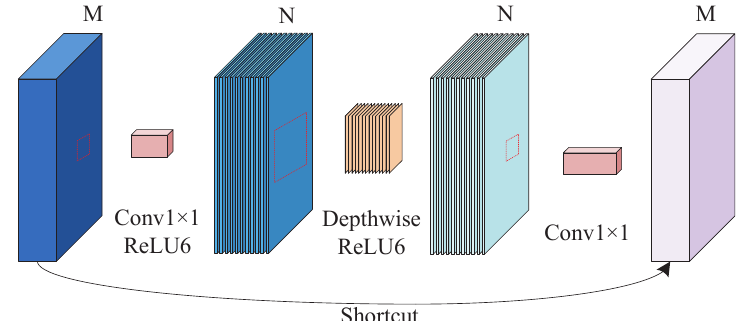
Figure 3. The linear bottleneck with shortcut connection in